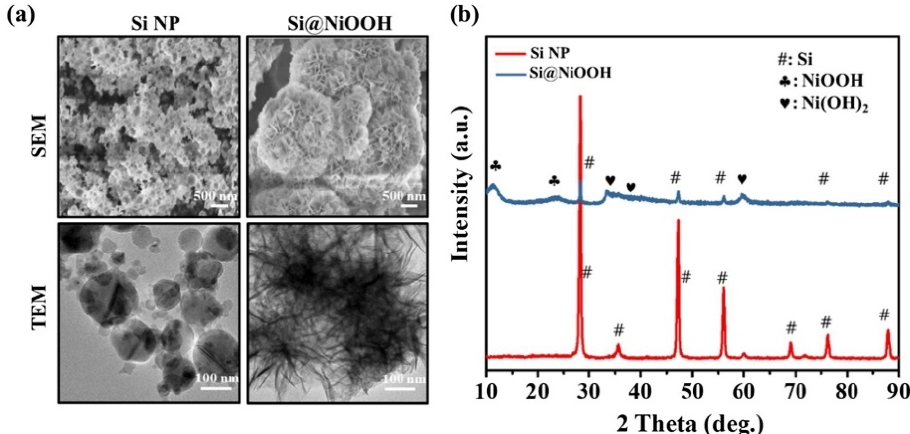
Figure 7. ( a ) SEM ( top ) and TEM ( bottom ) images of Si nanoparticles (SiNP) ( left ) and Si@NiOOH ( right ). ( b ) XRD of Si NP (red) and Si@NiOOH (blue). Scale bars = 500 nm and 100 nm, respectively. Reprinted with permission from Ref. [24]. Copyright 2021, Elsevier.